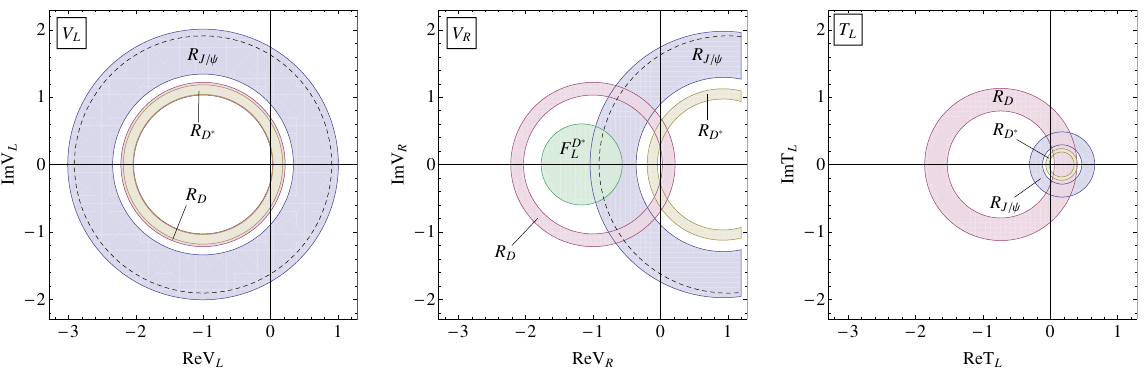
Figure 4. Constraints on the complex Wilson coefficients V L ( left ), V R ( center ), and T L ( right ) from the ( B → D ∗ τν τ ) within 1 σ , and from the branching fraction measurements of R D , R D ∗ , R J / ψ , and F D ∗ L B ( B c → τν τ ) ≤ 10% (dashed curve).